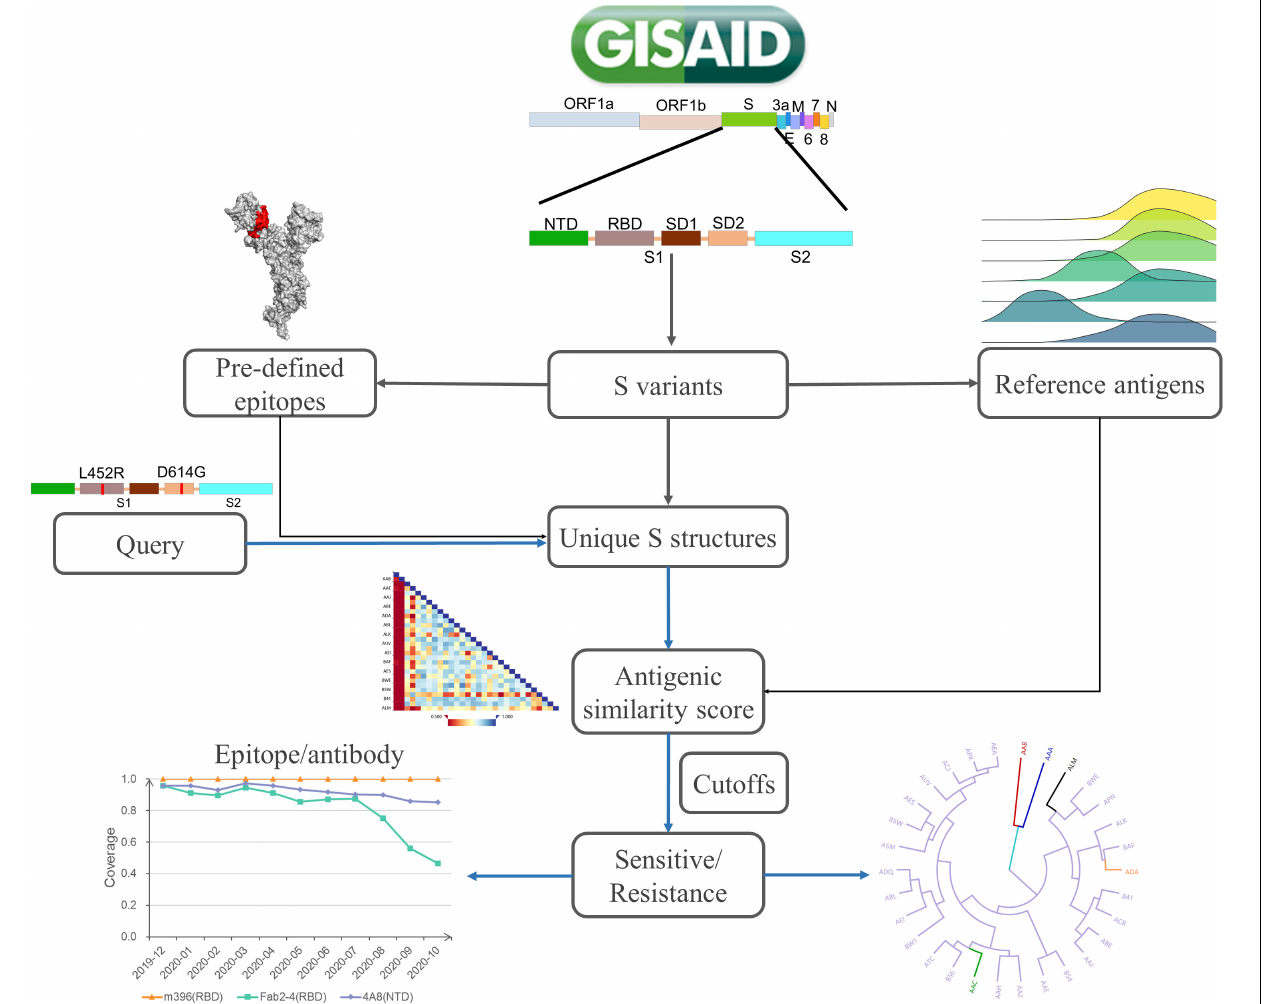
FIGURE 1 | The platform design of SAS. SAS can automatically derive S mutants from the whole-genome sequences collected in GISAID. After quality control, the structure of each S variant is constructed via Modeller 9.22. Pre-defined epitope regions are then mapped to modeled structures. For each queried variant, the pairwise antigenic similarity scores are calculated via CE-BLAST between query and reference antigens based on individual epitope region. Under a certain cutoff, the antigenic resistance can be suggested and the antigenic clustering tree can be visualized for cross-protection coverage among all reference S